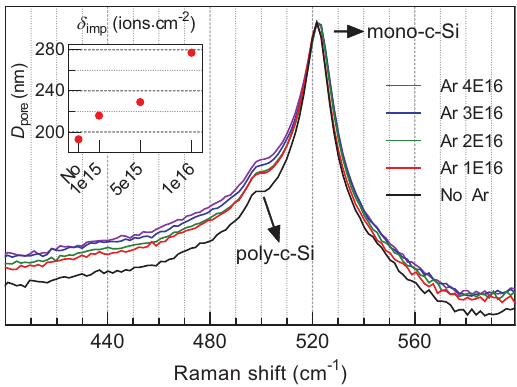
Fig. 5. Raman measurements of Ar implanted poly-Si sacri fi cial layers at phase 3 (post-anneal) at different d imp . Samples are processed with d asi =1.5 m m and E imp =250 keV. Raman measurements are normalized using the highest count and plotted on a semi-logarithmic scale. The inset show D pore as a function of d imp for P implanted sacri fi cial layers, with E imp = 5 keV and d asi =1 m m.